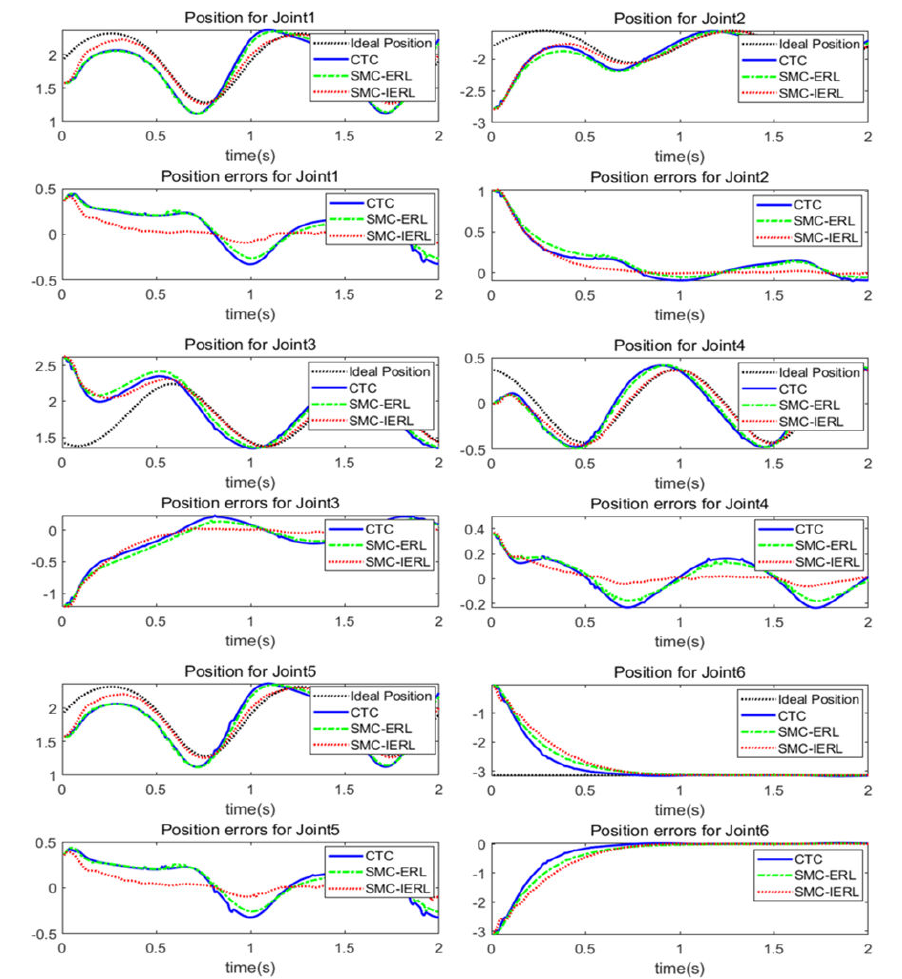
Figure 4. In the uniform circular trajectory experiment without considering disturbance signal, the expected position of each joint is compared with the position and error of each joint obtained by the three control